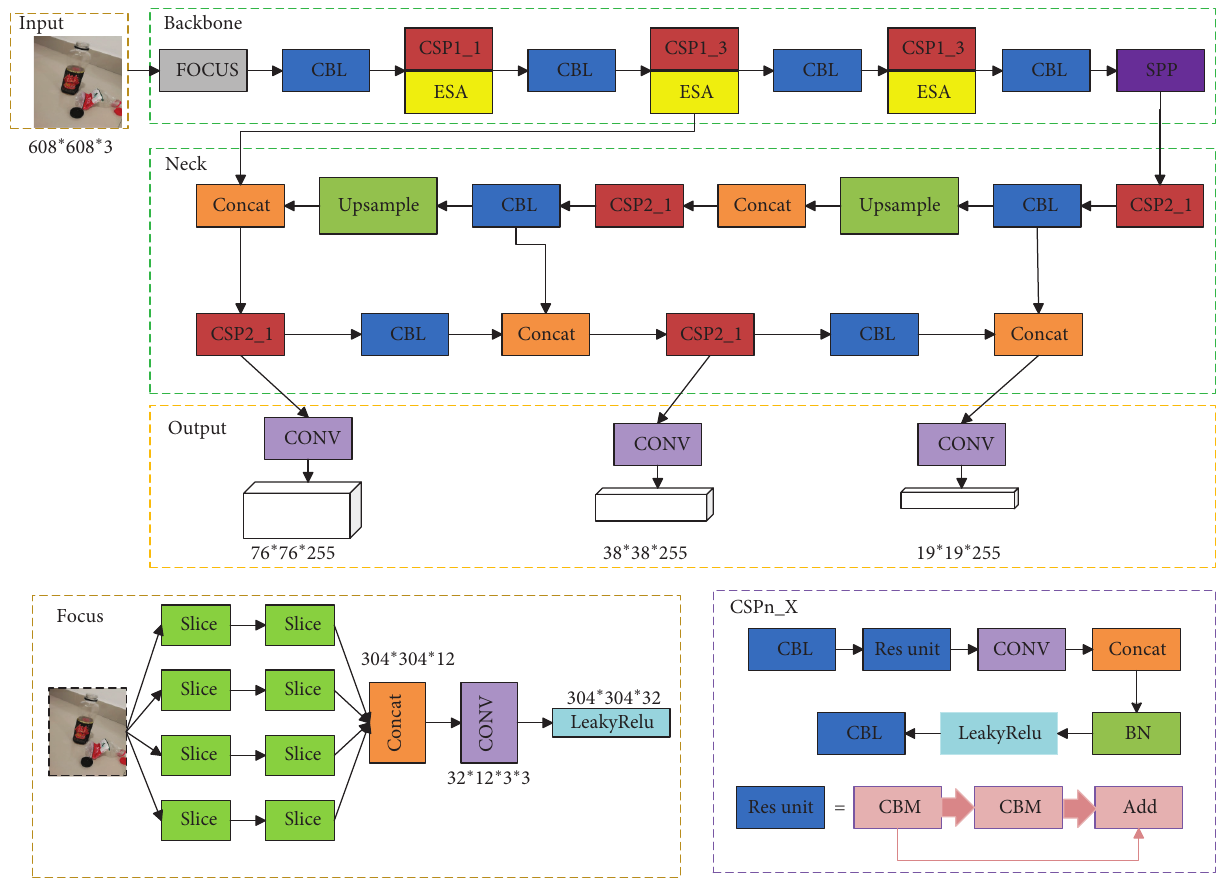
Figure 5: YOLOv5m-Attention network structure diagram.